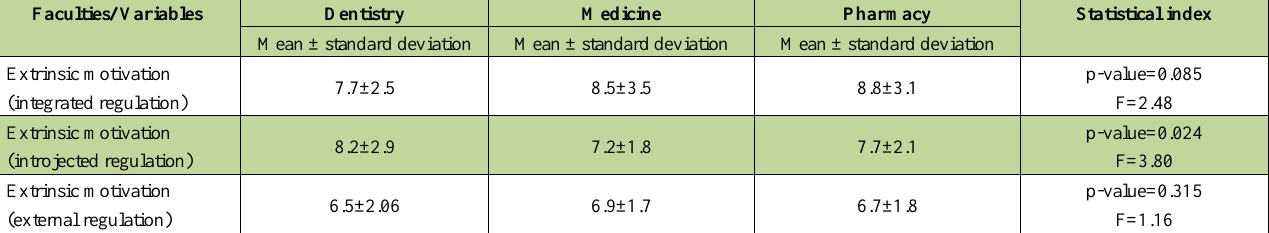
Table 2. Comparison of the mean scores of extrinsic motivation subscales based on dentistry, medicine, and pharmacy faculties. Faculties/ Variables